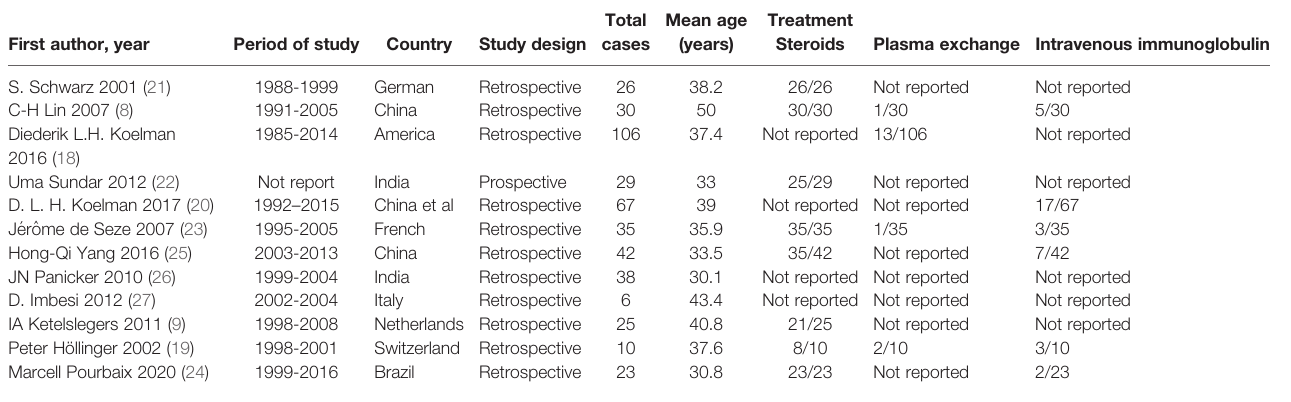
TABLE 1 | Characteristics of included studies in the meta-analysis.